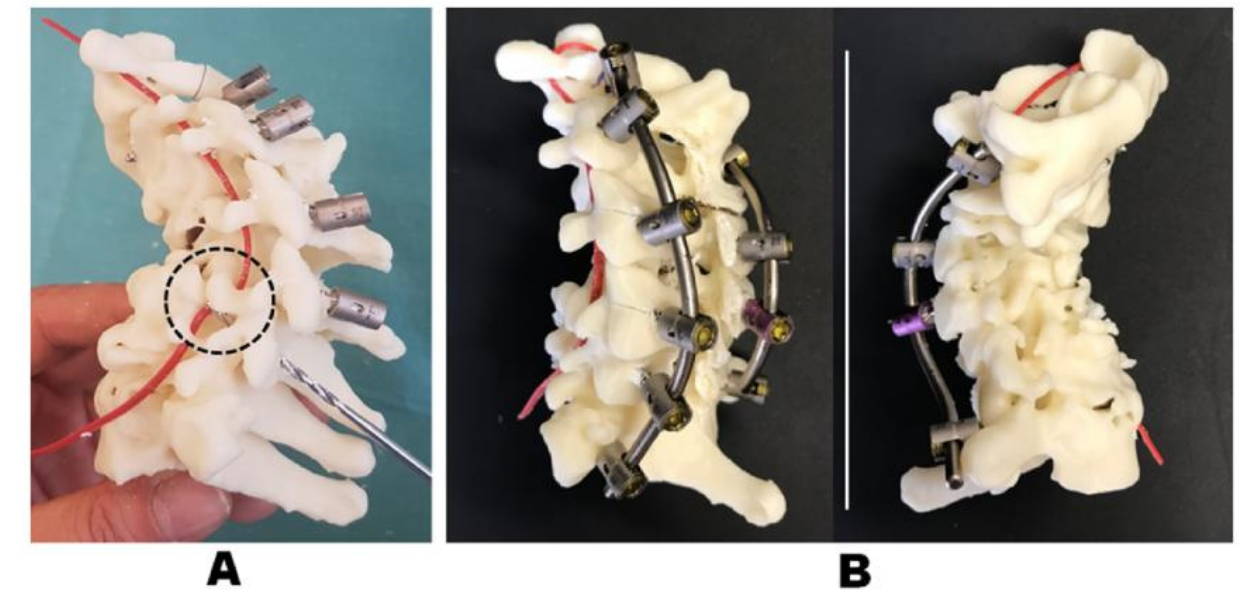
Figure 4. Pre-operative planning and surgical simulation on the patient-specific PRE-3DP. Prediction of likely vertebral artery injury due to improper screw insertion is depicted ( A ). Implanted fixation rods on final screw insertion locations are also shown in two views ( B ).